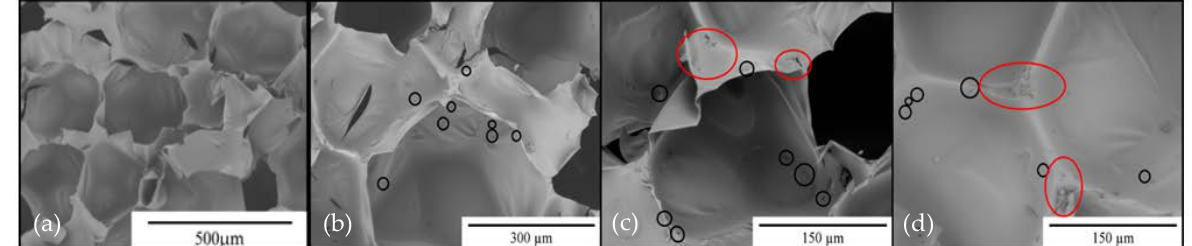
Figure 10. SEM images of ( a ) PU foam; ( b )PU/C1; ( c ) PU/C2; and ( d ) PU/C3 foams.